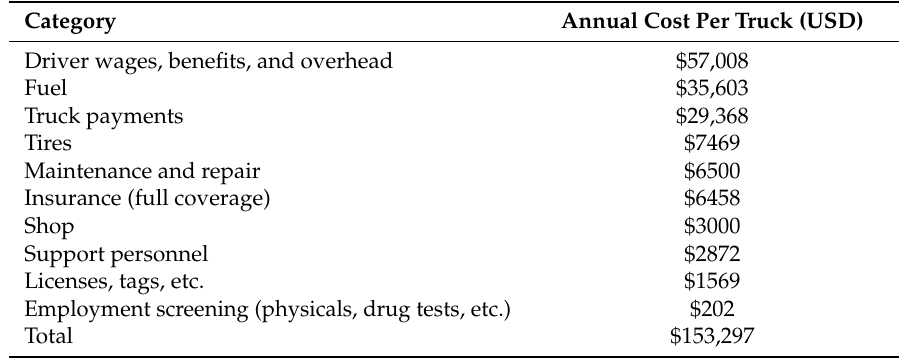
Table 3. Average annual cost to own and operate a new ( ≤ 5 years) log truck and trailer in Georgia, 2017. Category Annual Cost Per Truck (USD) Driver wages, benefits, and overhead $57,008 Fuel $35,603 Truck payments $29,368 Tires $7469 Maintenance and repair $6500 Insurance (full coverage) $6458 Shop $3000 Support personnel $2872 Licenses, tags,